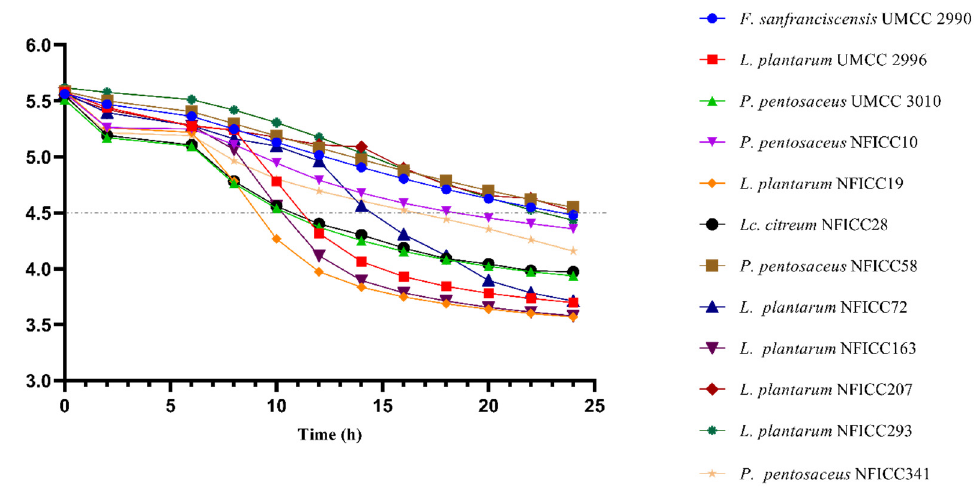
Figure 7. Acidification performance in Bread Medium showed by the best LAB candidates against bread rope-producing strains of Bacillus spp.